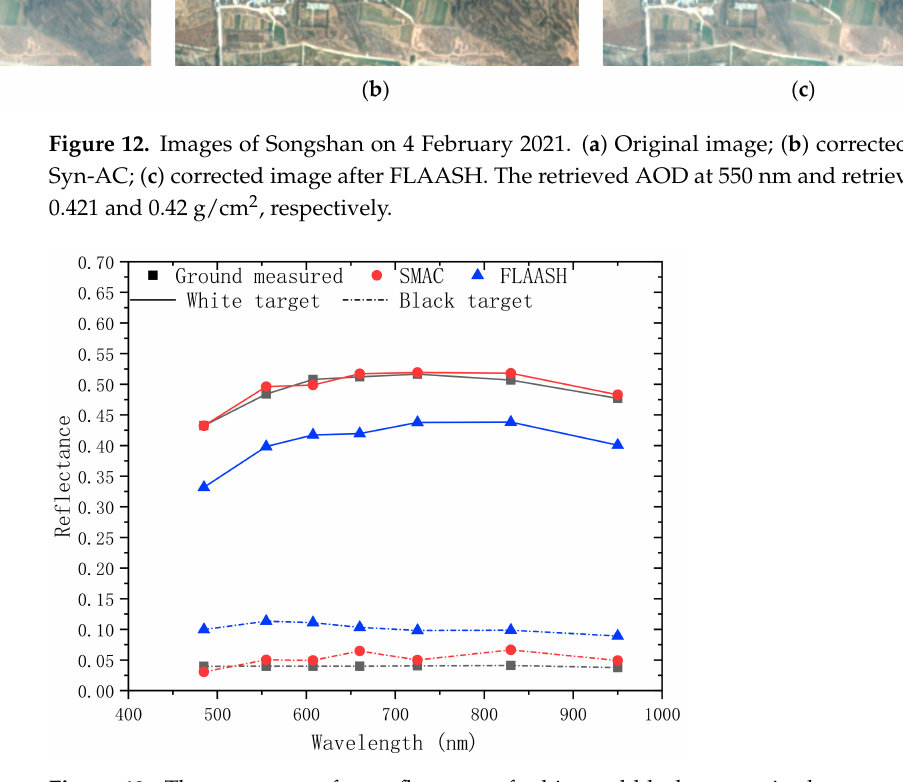
Figure 13. The average surface reflectance of white and black targets in the corrected image of Songshan on 4 February 2021 obtained from Syn-AC and FLAASH and the field-measured reflectance. Table 10. Performance comparison between Syn-AC and FLAASH, basing on Example